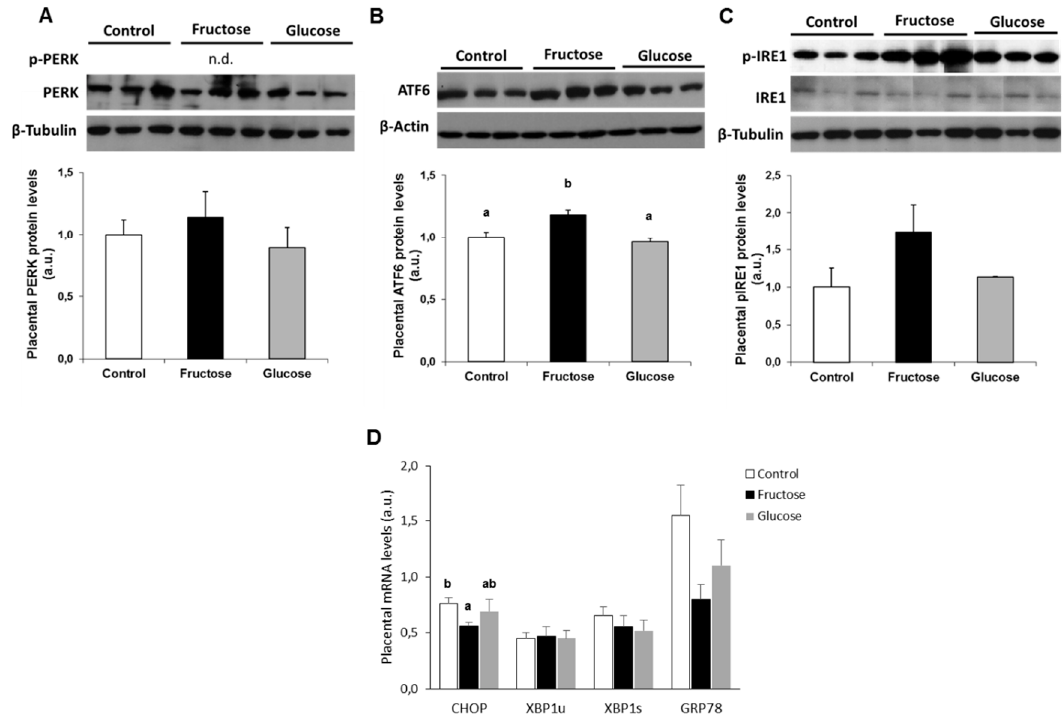
Figure 3. Maternal ingestion of a 10% w/v fructose solution throughout the gestation affects ER stress in placenta. Bar plots showing ( A ) total PERK, ( B ) total ATF6, and ( C ) the ratio between Ser-phosphorylated form, and the total IRE1 proteins in placental samples of control (empty bar), fructose- (black bar), and glucose-fed (grey bar) pregnant rats. Values were normalized to β -actin or β -tubulin levels and expressed in arbitrary units (a.u.). ( D ) Bar plots showing the relative hepatic levels of specific mRNA for target genes controlled by the three branches of the unfolded protein response (UPR) from placentas of control, fructose, and glucose pregnant rats. Results are the mean ± S.E. of values from 6–7 placental pools of the same litter for mRNA gene expression and 5 samples for protein expression. Values not sharing a common letter are significantly different at P < 0.05. n.d.: not detectable.